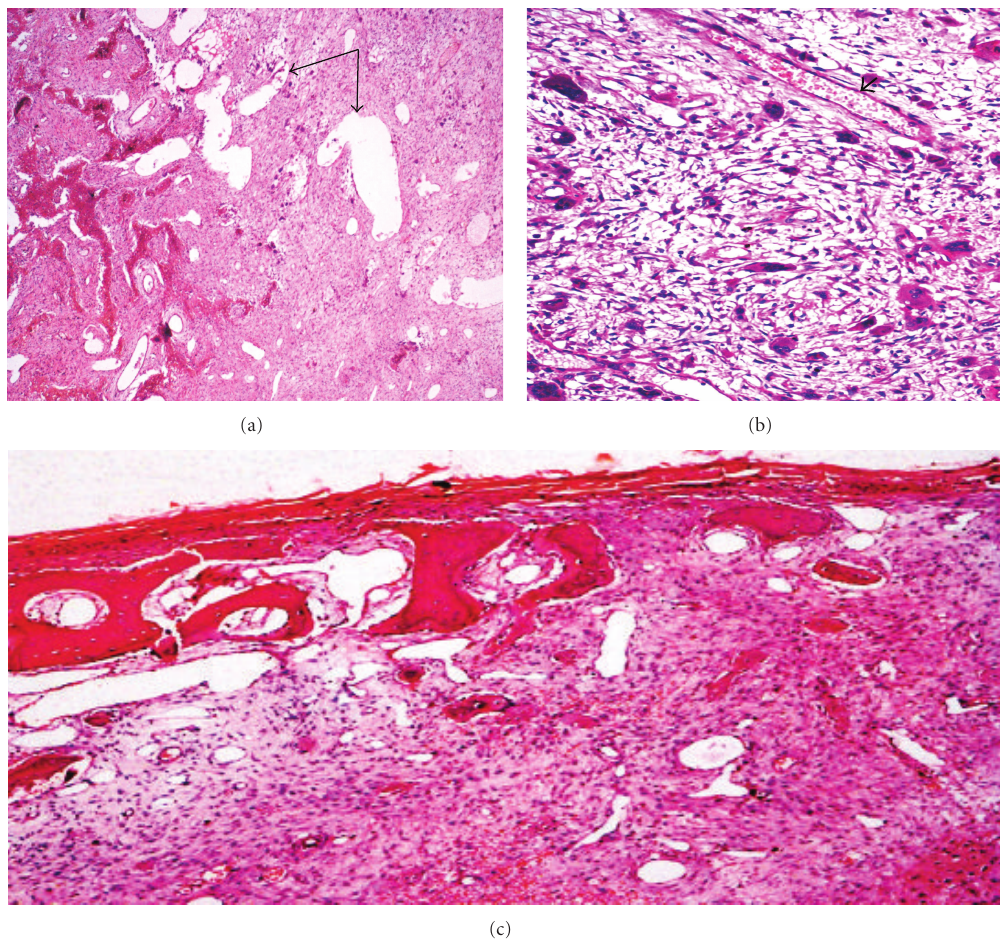
Figure 5: Microscopy, (a) FD (left) With ABC (right) changes—hemorrhagic spaces lined by osteoclast-like multinucleated giant cells (arrows) (H&E, 20x). (b) Osteoclast-like multinucleated giant cells lining hemorrhagic spaces (arrows) (H&E, 100x). (c) Intact periosteum with host lamellar bone and no soft tissue extension (H&E,